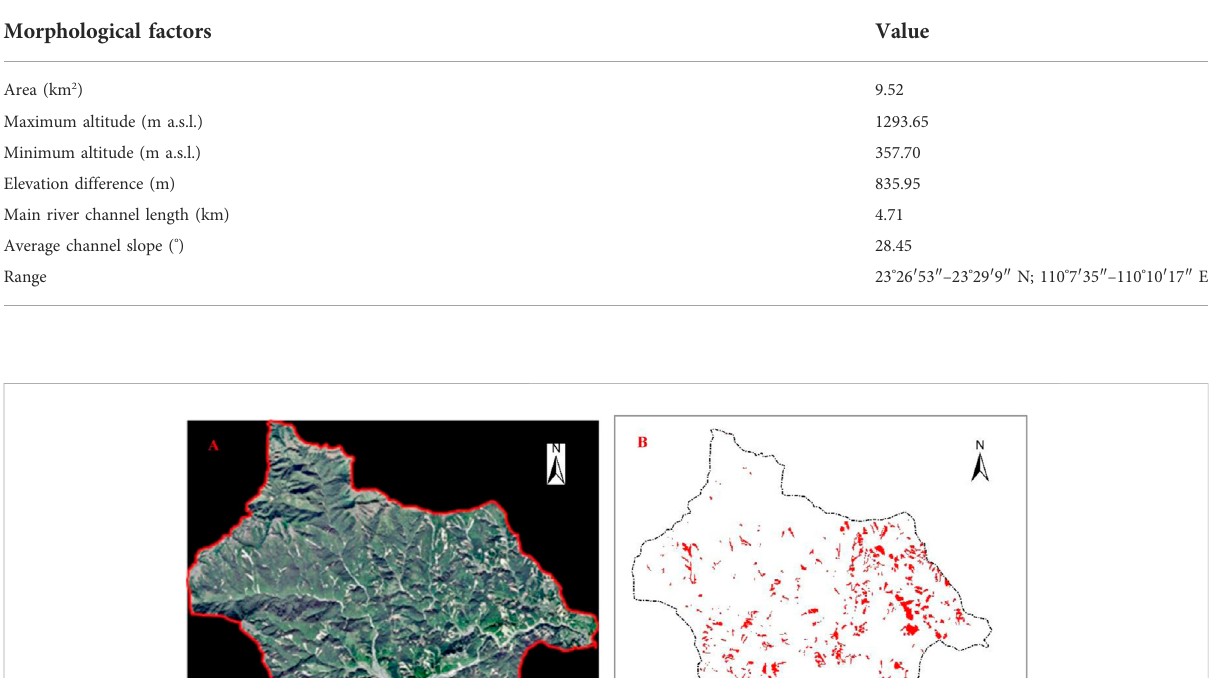
TABLE 1 Morphological characteristics of the study area.